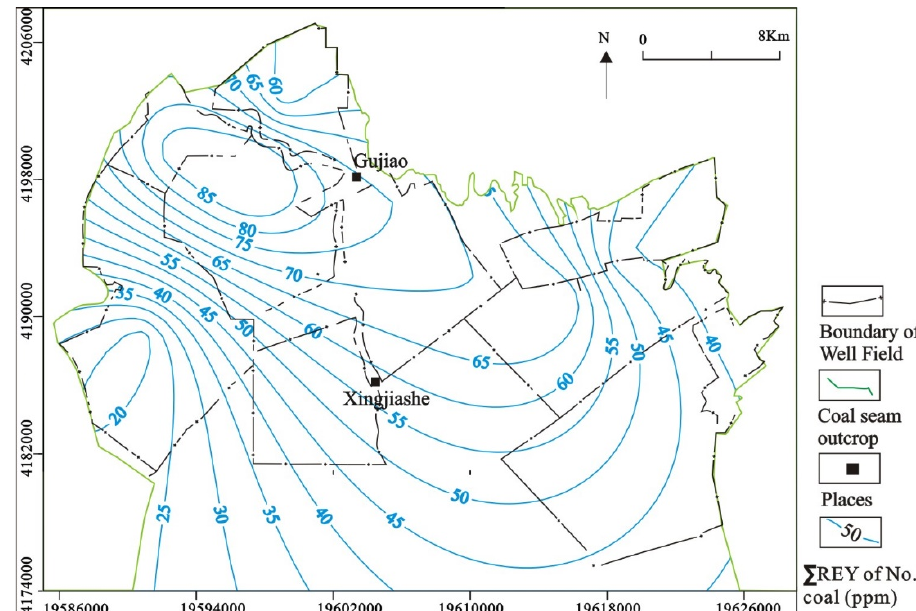
Figure 9. Total content of REY in No. 8 coal.